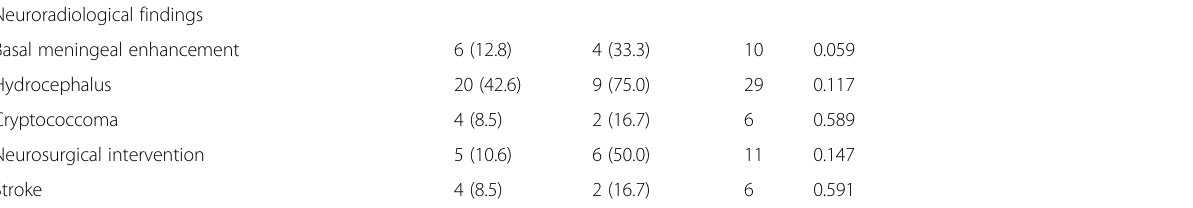
Table 1 Comparison of key variables between the survivor and deceased groups of CM patients (Continued) Neuroradiological